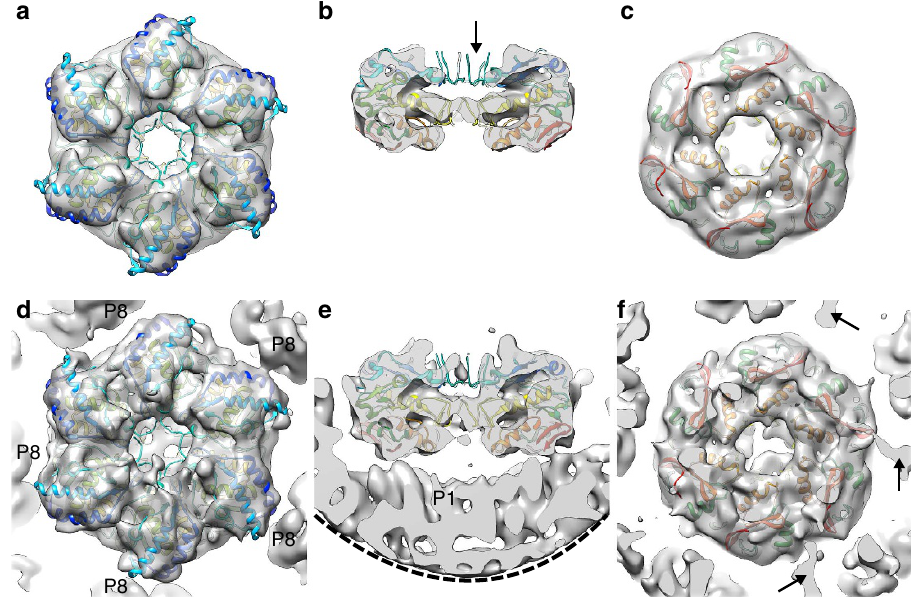
Figure 3 | Hexameric packaging ATPase P4. ( a – c ) Localized reconstruction of f 6 P4 with six-fold symmetry is shown as a grey transparent surface from the top ( a ), side ( b ) and below ( c ). P4 crystallographic structure 19 is coloured from red (C-terminus) to blue (N-terminus) and was fitted into the reconstruction as a rigid body. Flexible loops that were only partially resolved in the crystallographic structure were not resolved in the localized reconstruction (arrow). ( d – f ) Same views as in a – c showing the localized reconstruction without symmetry. The edge of a mask cutting through the density under the P4 hexamer is indicated with a dashed line in e . Three densities possibly connecting the P1 shell to the P4 C-termini are indicated with